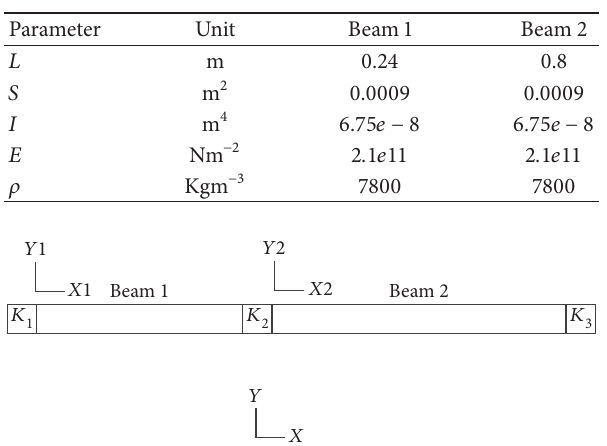
Table 2: Parameters of each beam.